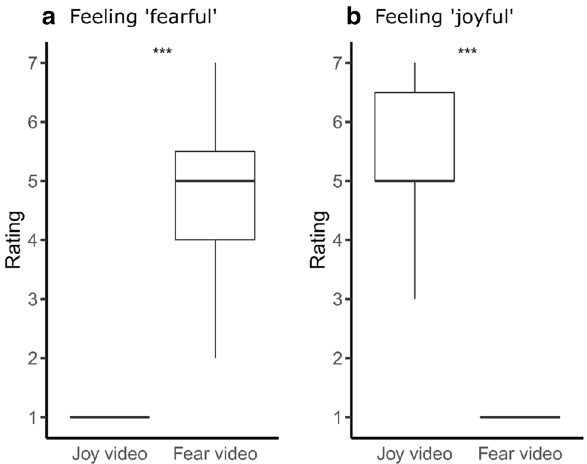
Figure 3. Emotion ratings reported by the participants after watching the fear- and joy-inducing videos. ( a ) Ratings for ‘fearful’. ( b ) Ratings for ‘joyful’. Boxplots show the median, first and third quartiles. Permutation tests, *** p ≤